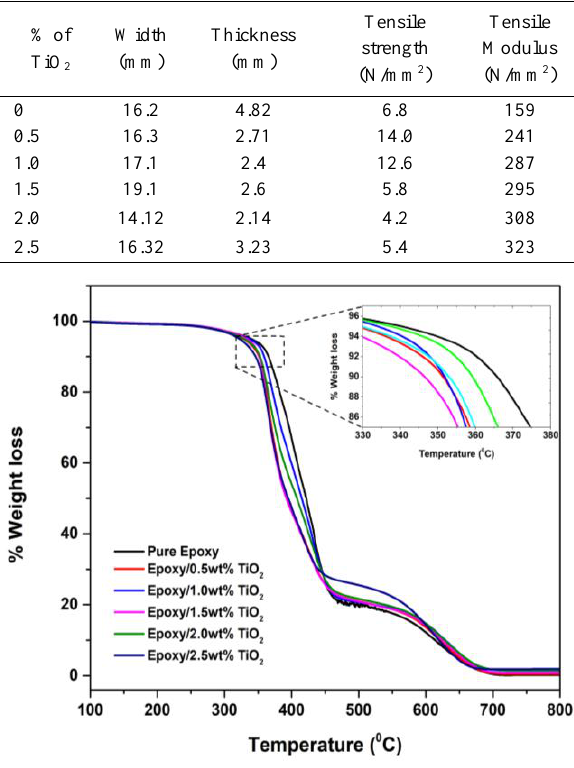
Fig. 4. Thermogravimetric analysis of epoxy and epoxy-TiO 2 nanocomposites